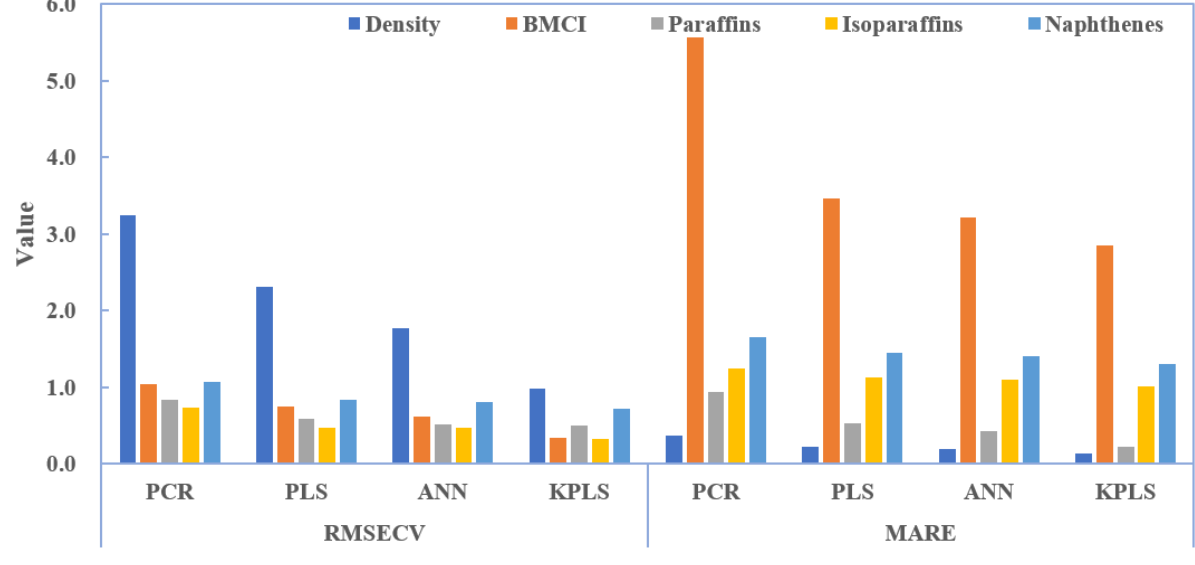
Figure 6. RMSECV and MARE of different methods (PCR, PLS, ANN, and KPLS) in the calibration subset.